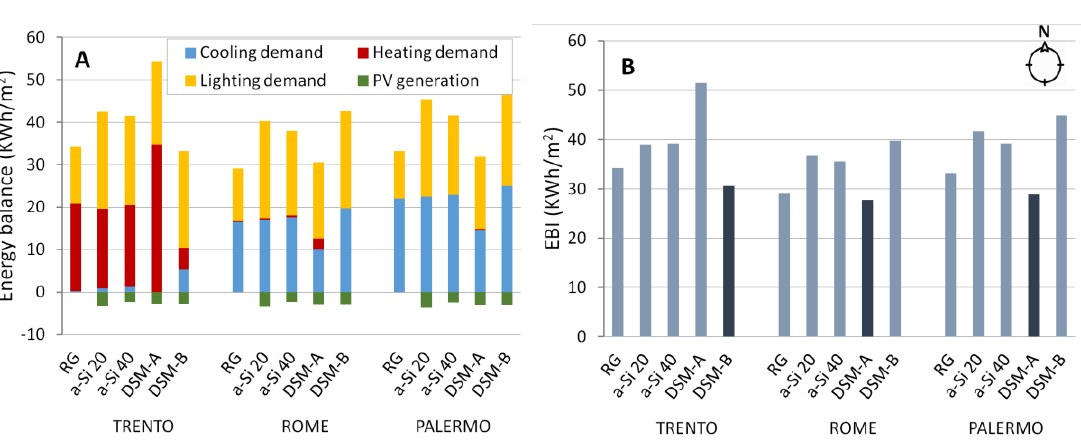
Figure 7. ( A ) Energy balance for the various STPV tested, compared to the reference glass (RG) of the STD building with northern exposure at the three locations; ( B ) Energy balance index (EBI) index evaluated for the same exposures and glazing